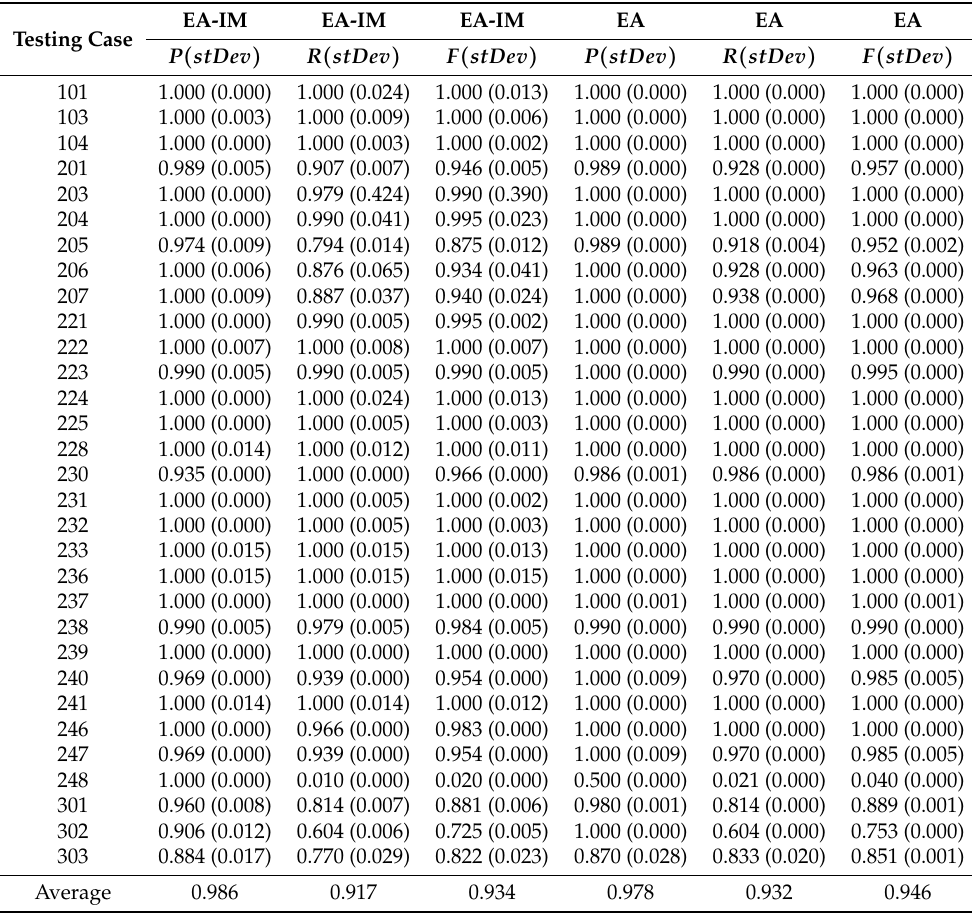
Table 2. Comparison between EA-IM and EA on OAEI’s